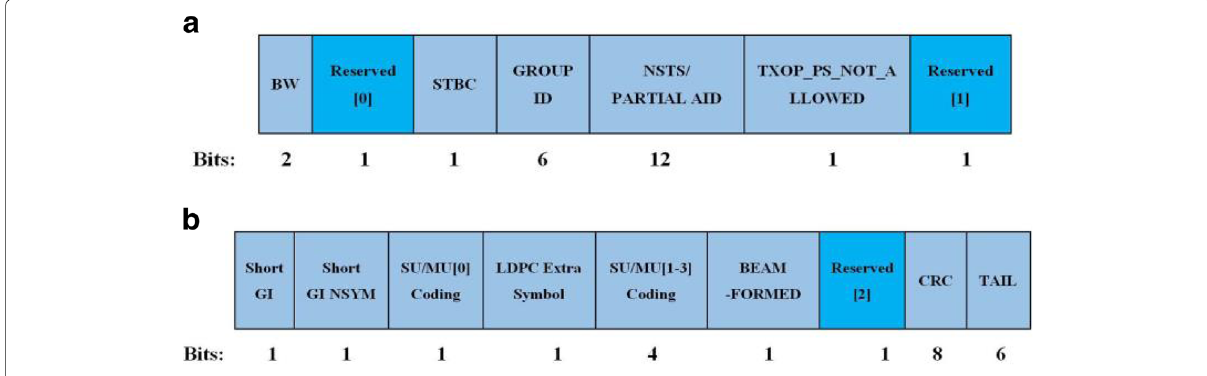
Fig. 6 Proposed HE-SIG field in IEEE 802.11ax: a HE-SIG-A1 and b